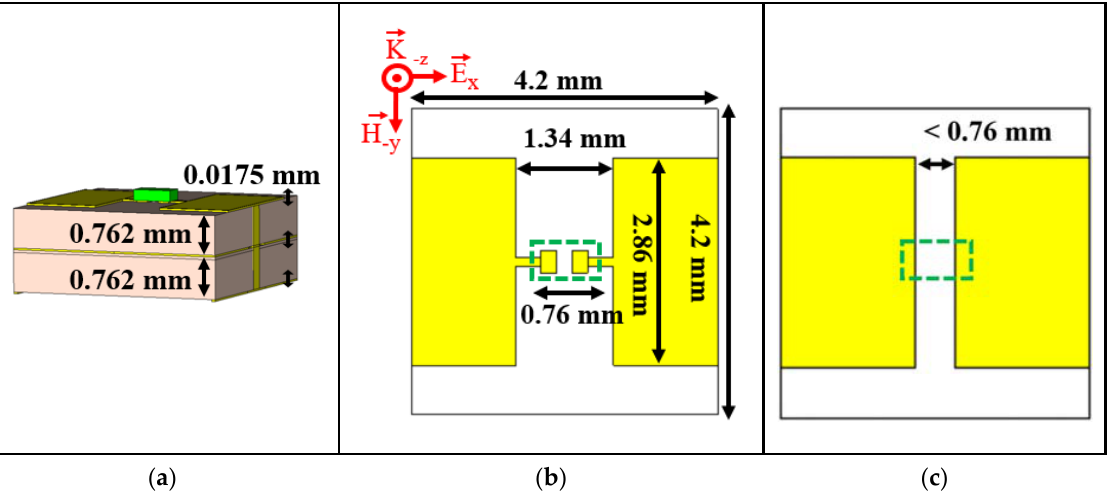
Figure 5. Unit cell design: ( a ) unit cell side view, ( b ) unit cell front side, and ( c ) standard patch unit cell design.